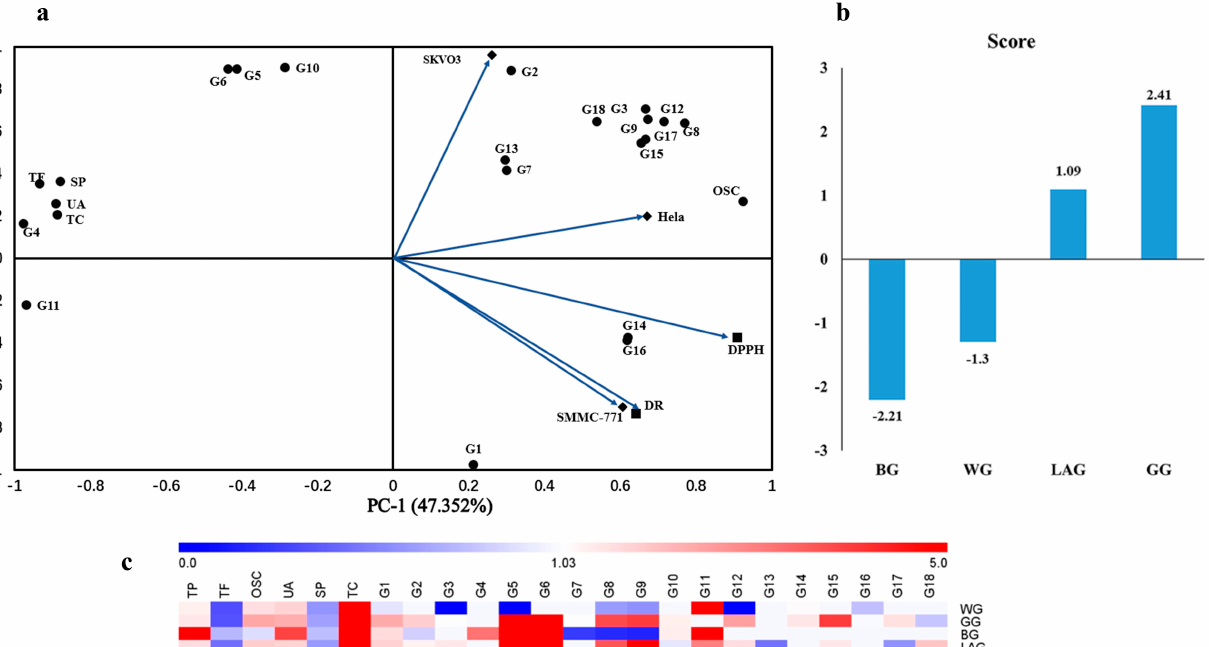
SKOV3: human ovarian cancer cells; and SMMC-7721: hepatocellular carcinoma cells.